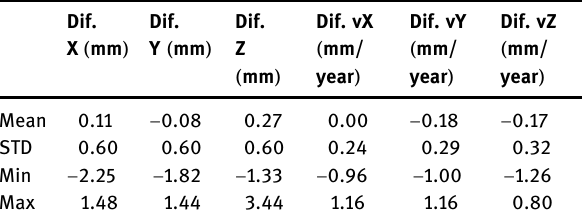
Table 5: Di ff erences between the IGb14 and SIRGAS2022 coordi - nates at IGS stations not used as fi ducial stations, stations AREQ ( Arequipa, Peru ) , and SANT ( Santiago de Chile, Chile ) are excluded from this comparison